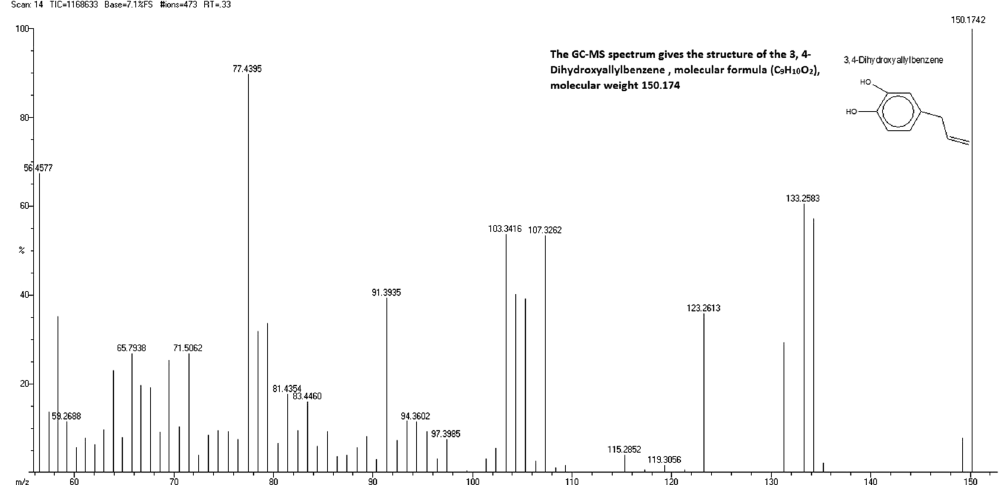
Figure 2. The GC-MS spectrum showing the structure of the APC, molecular formula (C 9 H 10 O 2 ) and molecular mass, 150.174.